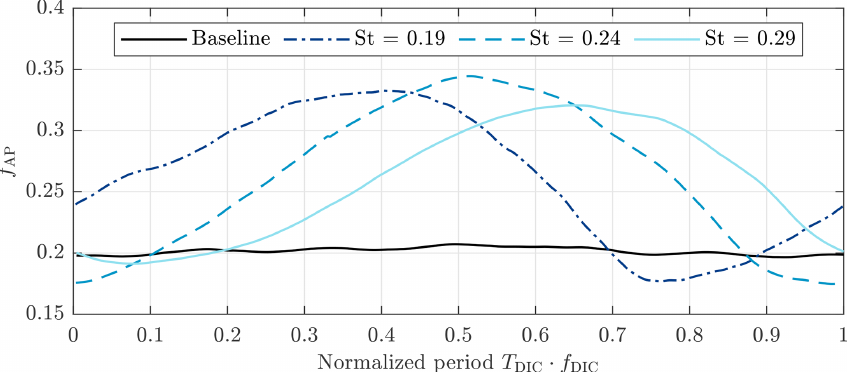
Figure 10. Available power f AP over time at a distance of x/D = 3. The results have been normalized over time using the corresponding pitch frequencies in order to compare the results over a single pitch cycle. The different measurements have been synchronized using the pitch reference signal.